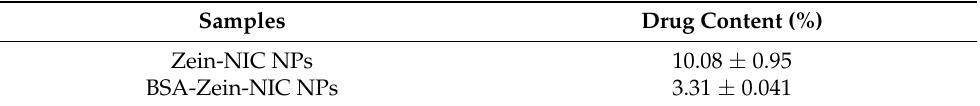
Table 2. Drug content analysis of Zein-NIC and BSA-Zein-NIC NPs ( n = 3).